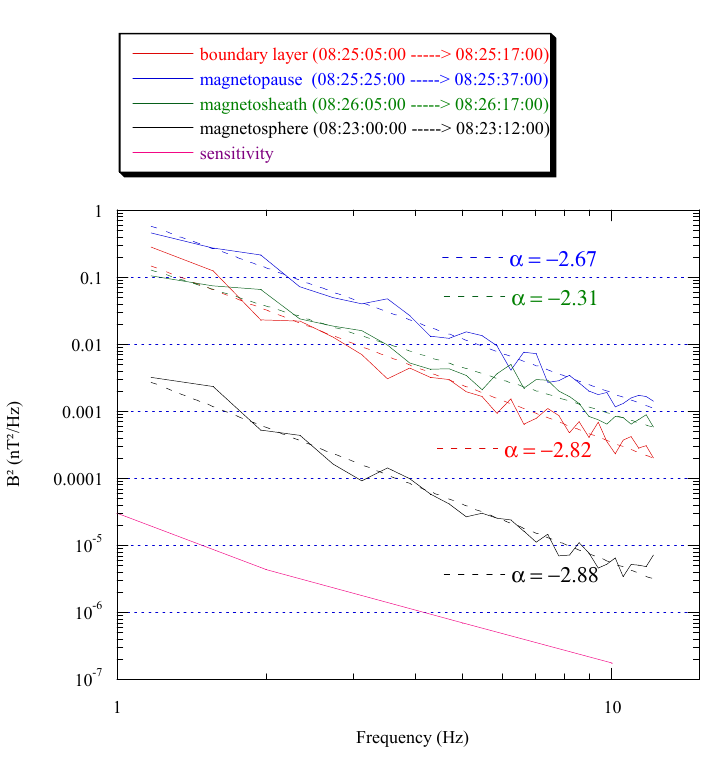
Fig. 5. Comparison of the spectra in the regions adjacent to the magnetopause on spacecraft 2. For reference, the sensitivity of the instrument is plotted showing that the fluctuations are much higher, even in the